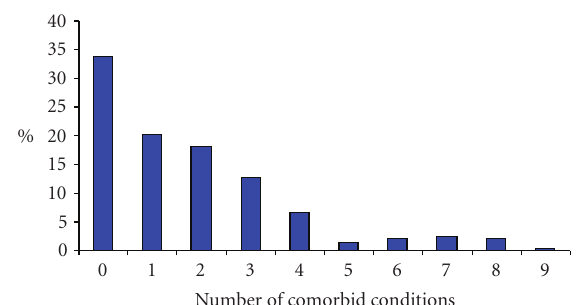
Figure 1: Number of comorbid conditions in patients with ankylosing spondylitis commencing biological therapy ( n = 198).